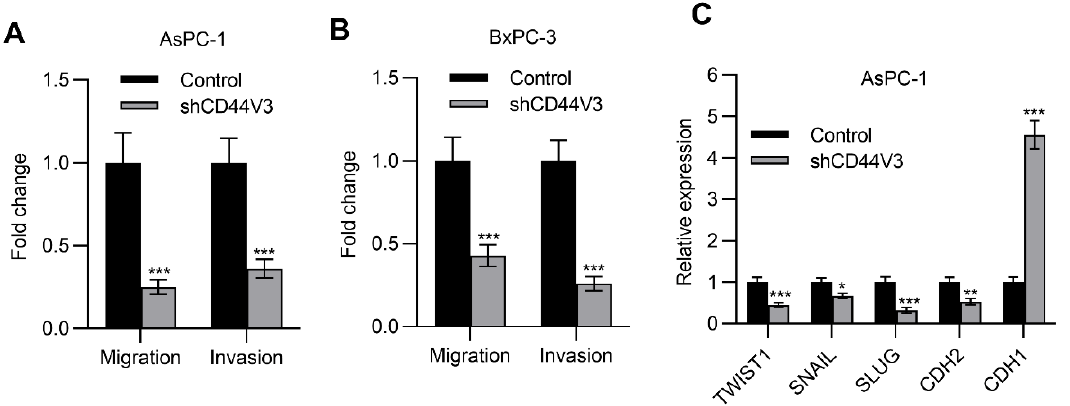
Figure 4. Downregulation of CD44V3 inhibited pancreatic cancer cell invasion. ( A ) Transwell migration and invasion assay of AsPC-1 cell transfected with CD44V3 shRNA. ( B ) Transwell migration and invasion assay of BxPC-3 cell transfected with CD44V3 shRNA. ( C ) A panel of EMT markers in AsPC-1 cells transfected with CD44V3 shRNA was determined by qPCR. The data are presented as mean ± S.D. * p < 0.05; ** p < 0.01; *** p < 0.001.